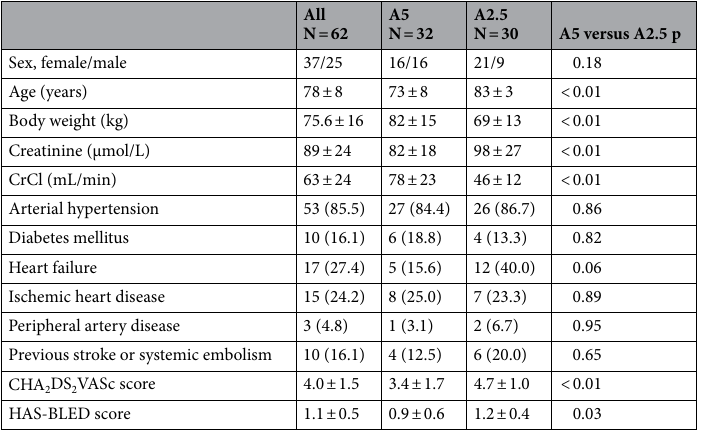
Table 1. Characteristics of the patients on apixaban 5 mg (A5) or 2.5 mg (A2.5) twice a day. Average ± SD or number of cases (%) is given. CrCl creatinine clearance estimated by the Cockcroft–Gault